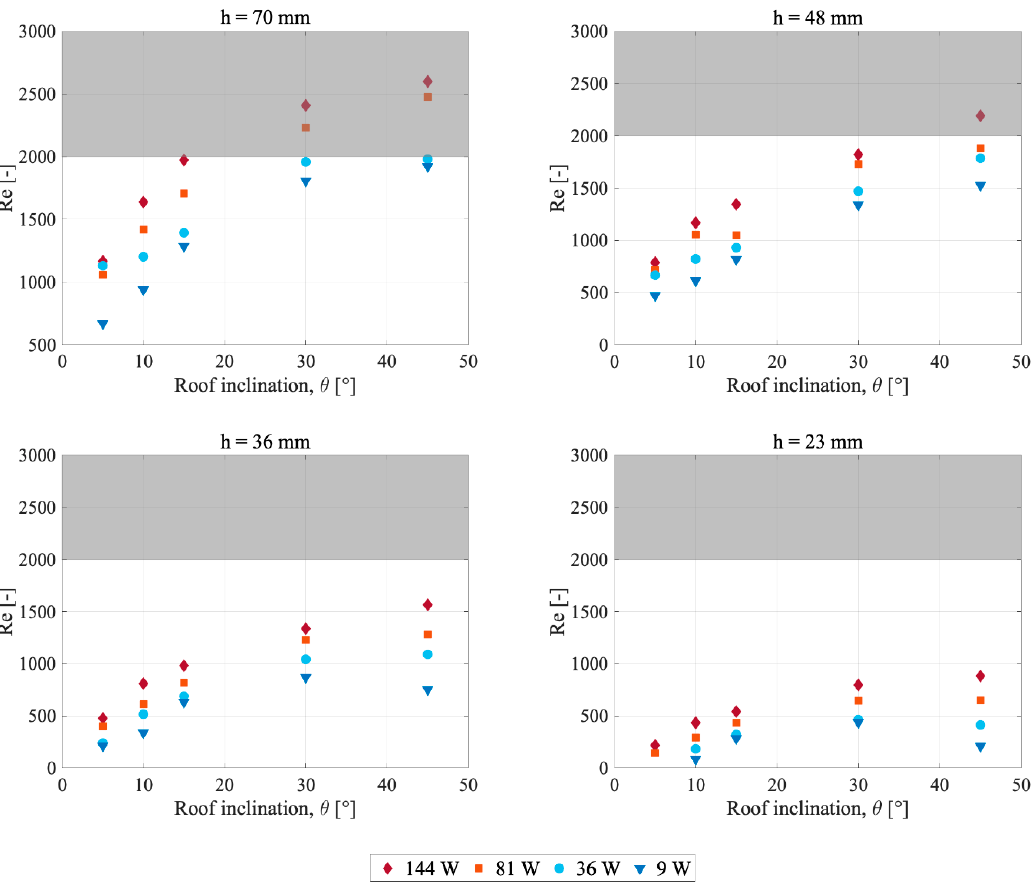
Figure 9. Reynolds number, Re , as a function of roof inclination. The shaded area represents possible beginning of the transitional flow region.